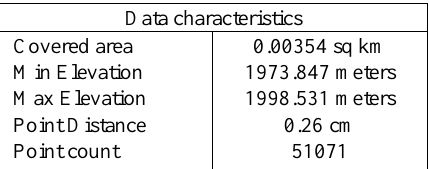
Figure 4. (a) image before segmentation and (b) image after segmentation.